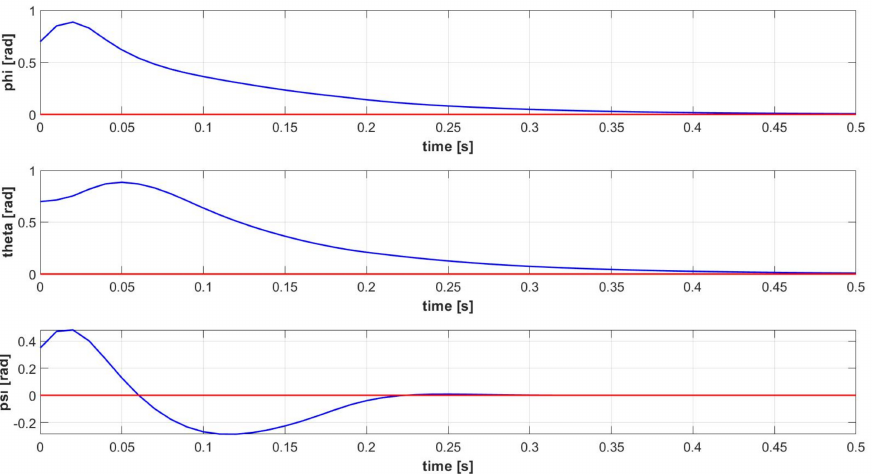
Figure 6. Euler angles signals [ φ ( t ) , ϑ ( t ) , ψ ( t ) ] of the controlled attitude system (blue): FL-based Attitude Stabilizer (red).